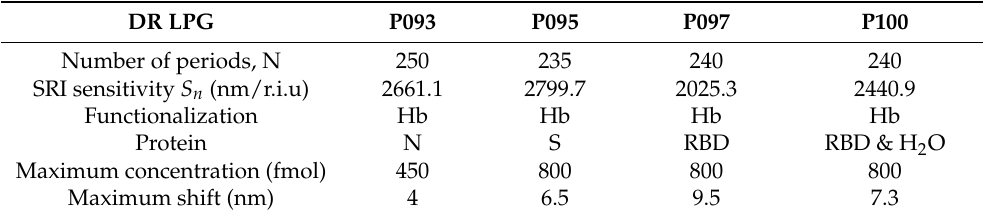
Table 1. Sensitivities S n to SRI, the type of functionalization, the detected proteins, and the maximum shifts of the DR LPGs used in the